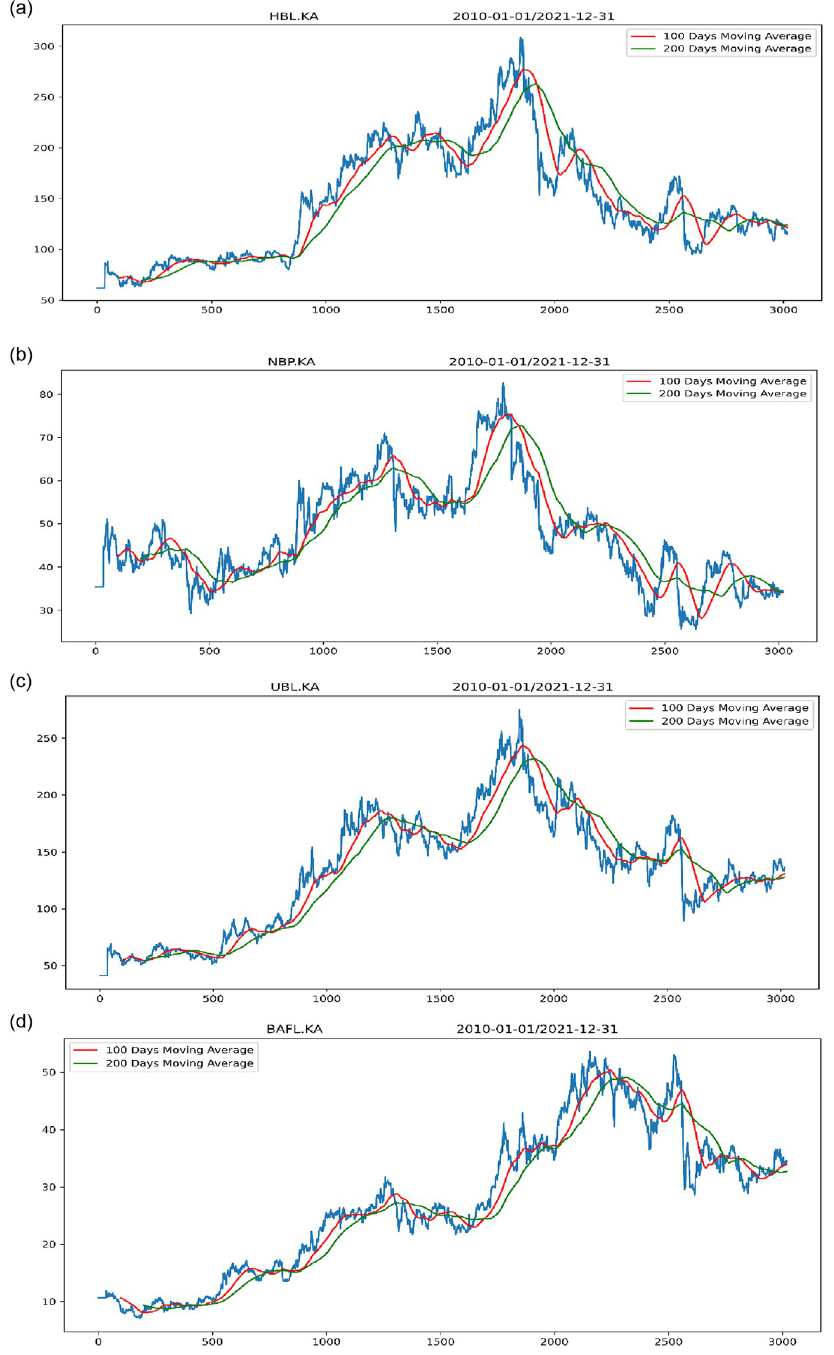
Fig 7. Stock crisis point. (a) HBL Bank. (b) NBP Bank. (c) UBL Bank. (d) Bank